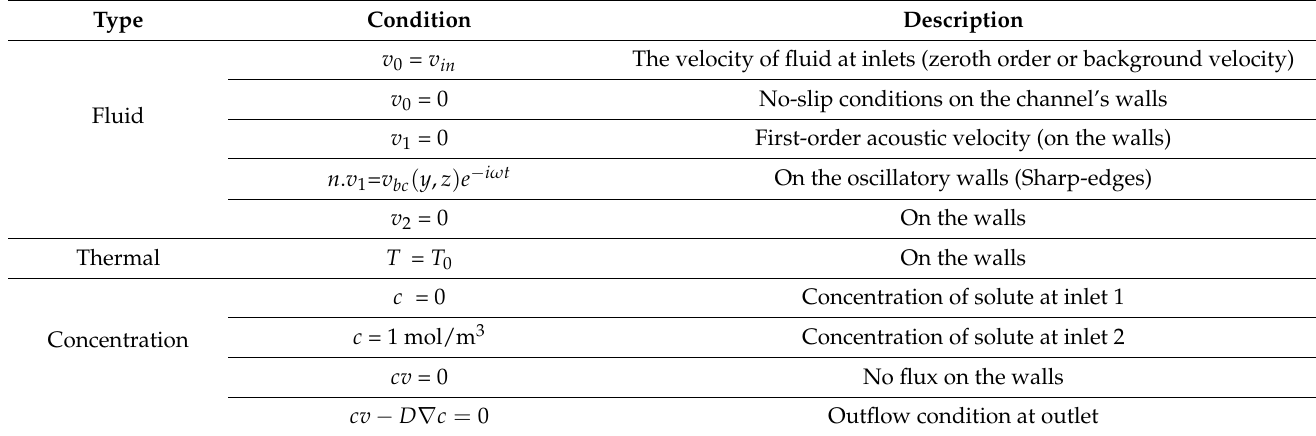
Table 1. The boundary conditions used for simulation.